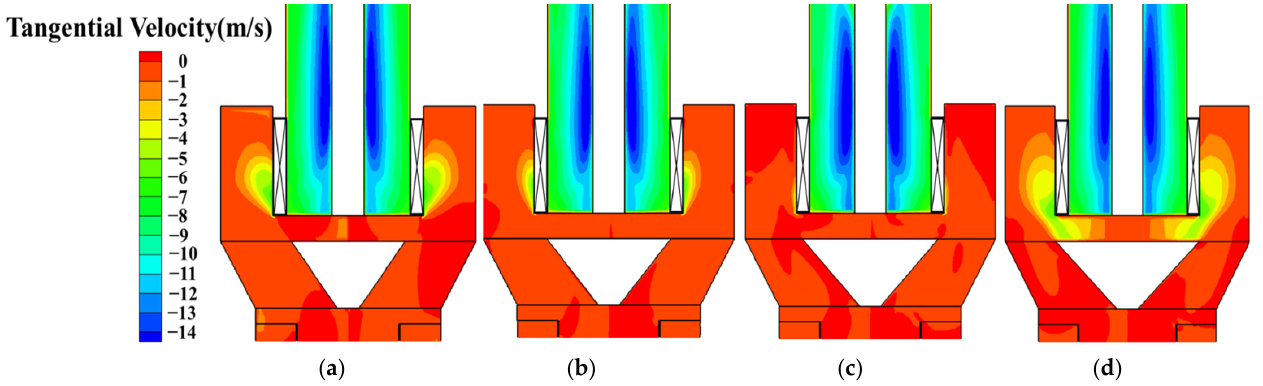
Figure 15. Effect of the guide cone diameter on the tangential velocity: ( a ) D = 196 mm, ( b ) D = 216 mm, ( c ) D = 236 mm, ( d ) D = 256 mm.